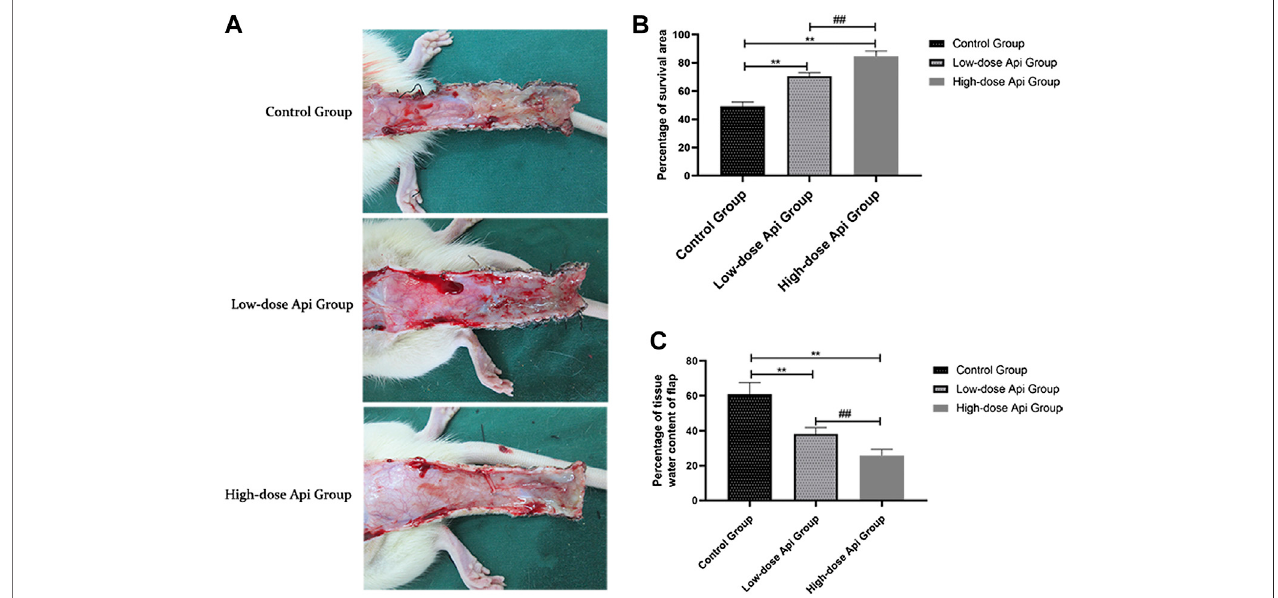
FIGURE 2 | (A) Digital photographs of dorsal skin fl aps in rats from the three groups. Macroscopic comparison of the overall appearance of the surviving and necrotic areas of the fl ap. (B) Percentage of survival area on day 7. Api increased the survival rate of skin fl aps. (C) Percentage of tissue water content on day 7. Api reduced the degree of tissue edema in skin fl aps.** p < 0.01 vs. control group. ## p < 0.01 vs. Low-dose Api group.